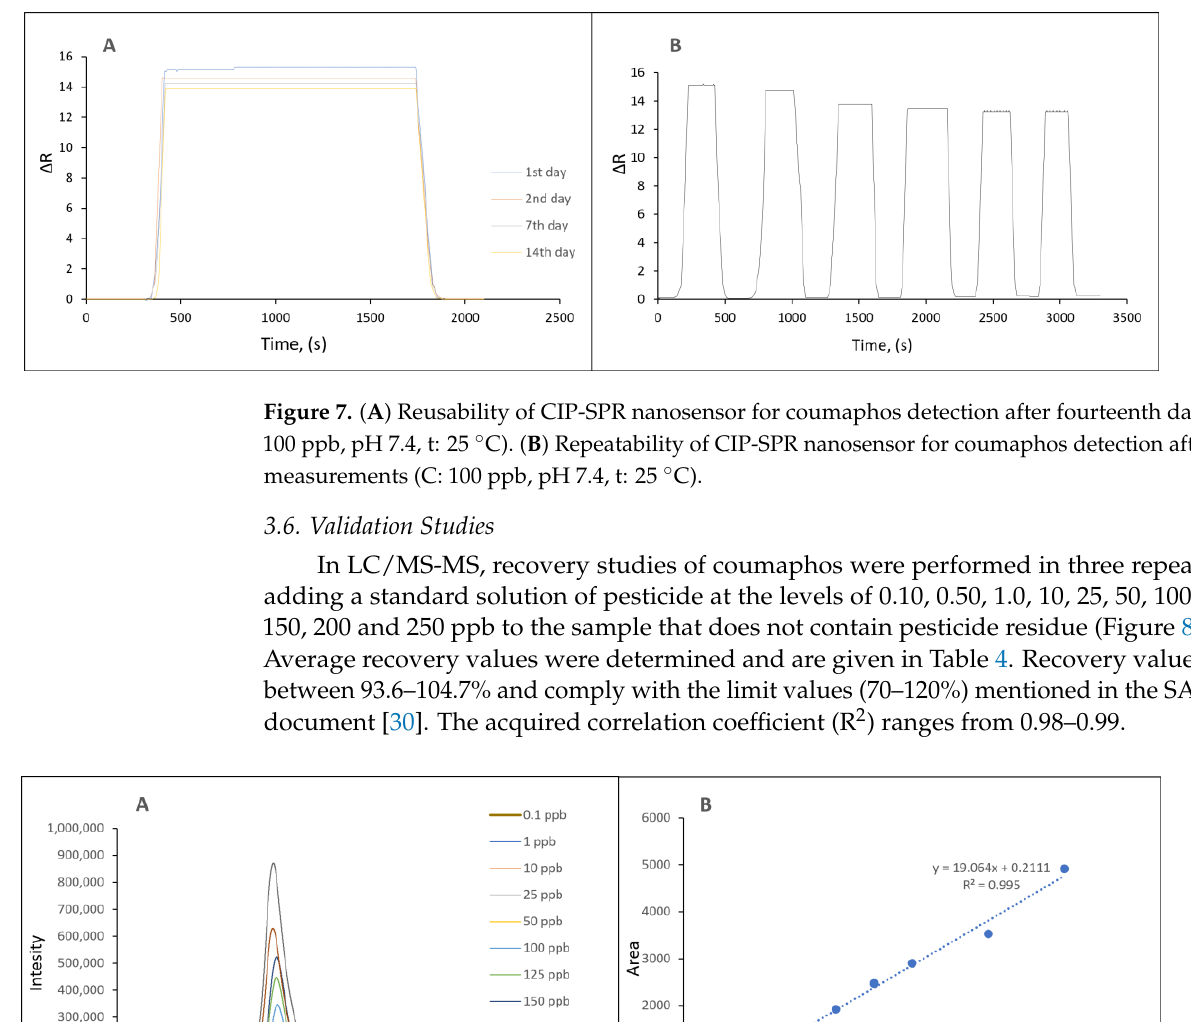
Figure 7. ( A ) Reusability of CIP-SPR nanosensor for coumaphos detection after fourteenth days (C: 100 ppb, pH 7.4, t: 25 °C). ( B ) Repeatability of CIP-SPR nanosensor for coumaphos detection after six measurements (C: 100 ppb, pH 7.4, t: 25 °C).